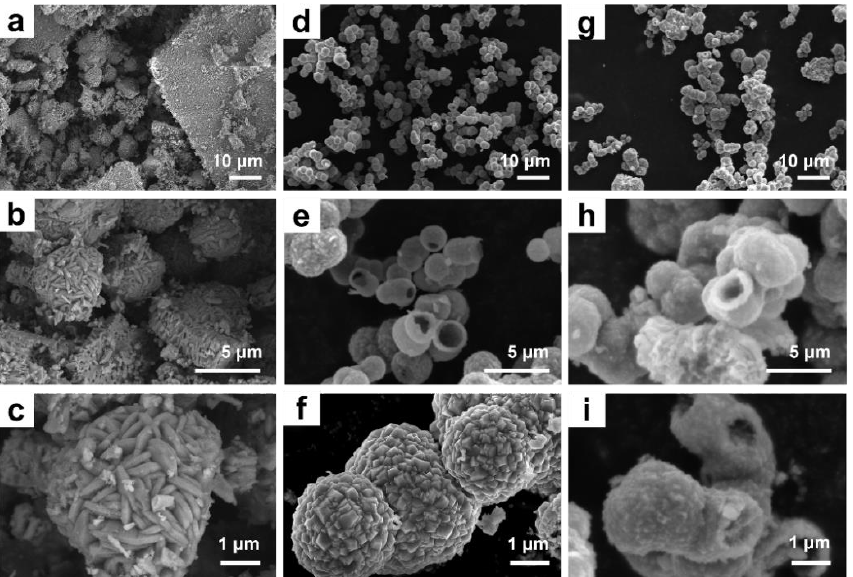
Figure 3. SEM of α -Fe 2 O 3 /RT prepared with varying additions of phosphate: ( a – c ) 0 mM, ( d – f ) 0.025 mM, and ( g – i ) 0.042 mM.